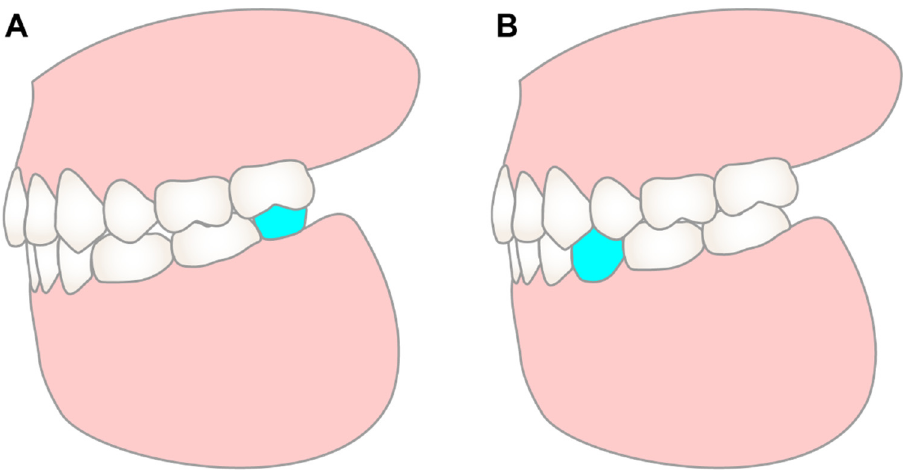
Figure 4. The illustration of different treatment options. Both treatment options involve the distalization of the maxillary arch and achieving class I molar and canine relationships on the right side. While for the left side, both options will use the mandibular left canine to substitute the mandibular left lateral incisor, and use the mandibular left first premolar to substitute the mandibular left canine. The difference between the two options is: option 1 ( A ) will finish in class III molar relationship on the left side, and place a retromolar implant (blue) to articulate with the maxillary left second molar; option 2 ( B ) will distalize the mandibular left molars to achieve class I molar relationship, and open space for a premolar implant (blue).